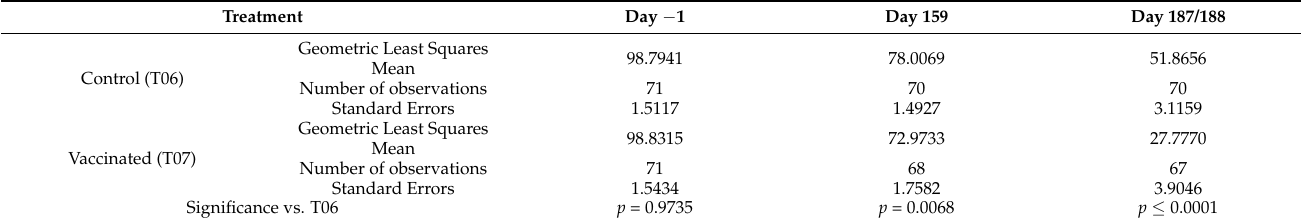
Table 7. Mhyo serology (Least Squares Means, Standard Errors and Significance values) per treatment and day of study.